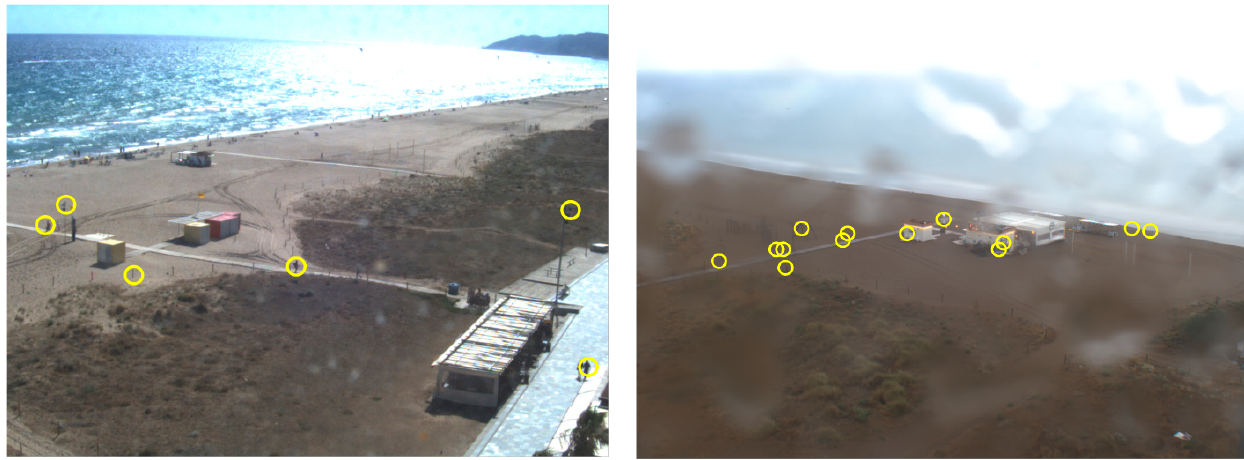
Figure 5. Image result of the detection algorithm for images with issues (blurry, left ; rainy, right ) at Castelldefels beach.